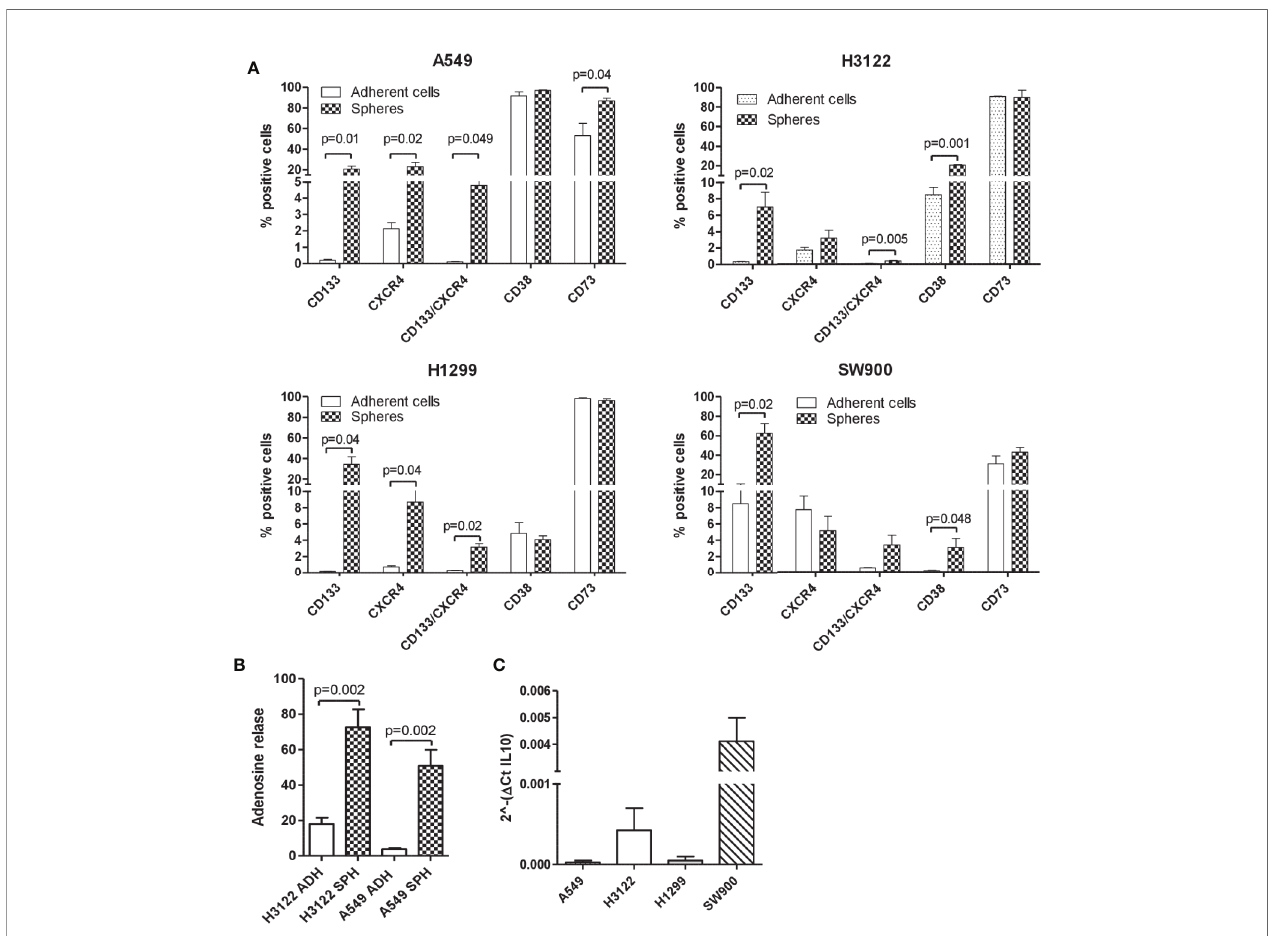
FIGURE 2 | Lung spheroids are enriched in MICs and expressed high level of immunosuppressive markers then adherent cells. (A) FACS analysis of adherent NSCLC cell lines (A549, H3122, H1299, SW900) and corresponding spheroids for expression of CD133, CXCR4, CD38, and CD73 markers. Data are the mean value ± SD of n=4 analyses for each cell line. (B) AMP substrate was added to culture medium and generation of adenosine was quanti fi ed by HPLC in the medium of spheroids and adherent cells (A549 and H3122 cell lines). Data are the mean value ± SD of n=2 analyses for each cell line. (C) IL-10 gene expression evaluated by Real-Time PCR in lung spheroids cultures. Bar are the mean value ± SD of 2 - (CT IL-10-CT B2m)